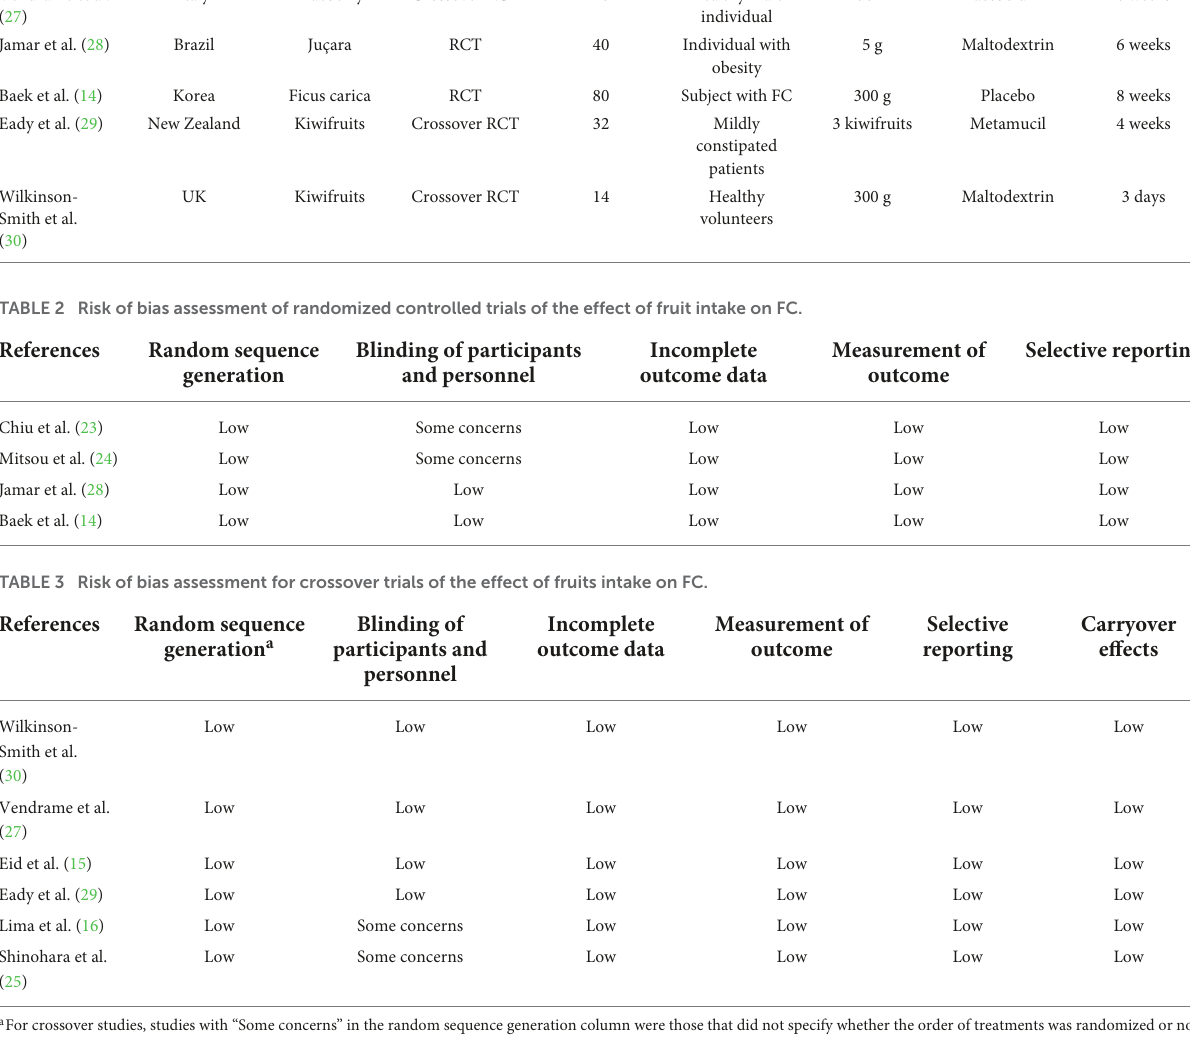
kiwifruits have a better effect [MD = 0.67, 95% CI (0.24, 1.10), P < 0.05, Figure 7 ] than ficus carica paste on the symptom of the FC assessed by the Bristol stool scale in the fixed-effect meta-analysis. Fruits vs. placebo have no effects on the L. acidophilus of patients with FC in the random-effect meta-analysis [MD =